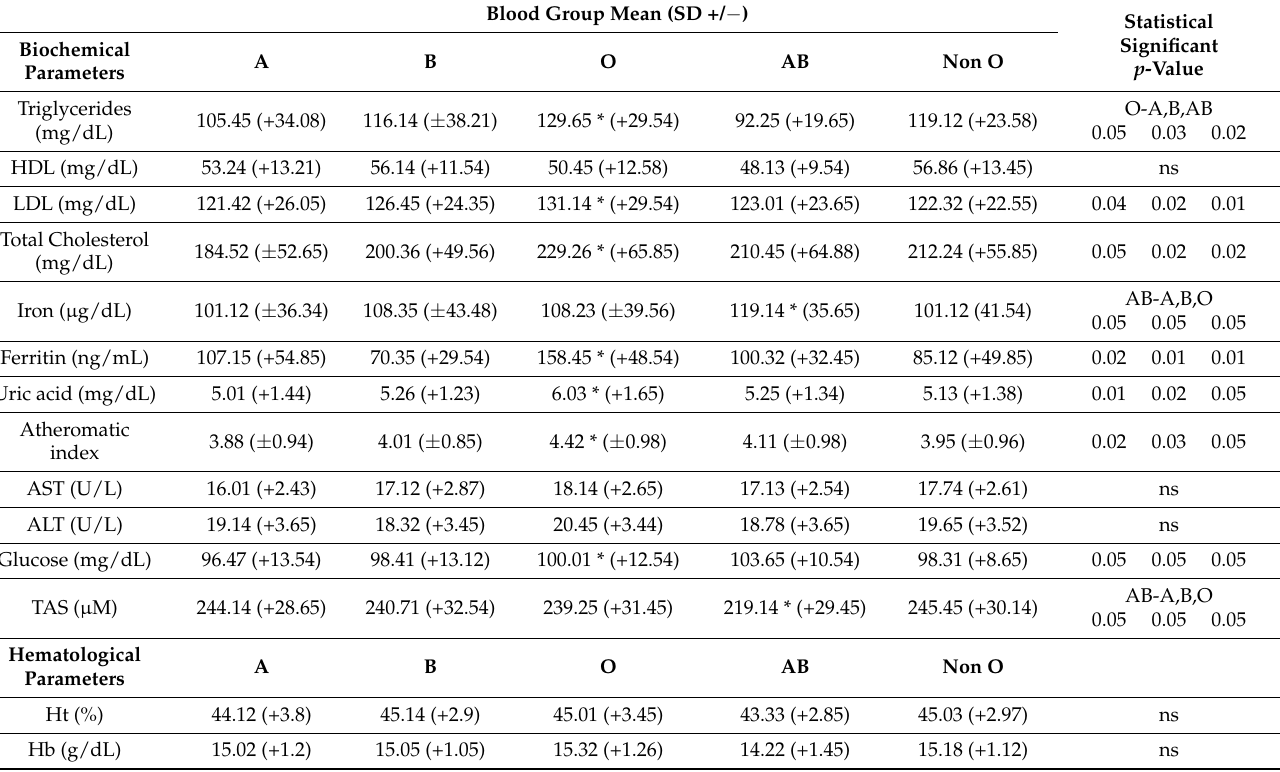
Table 3. Biochemical and hematological parameters related to ABO blood system. Blood Group Mean (SD +/ −